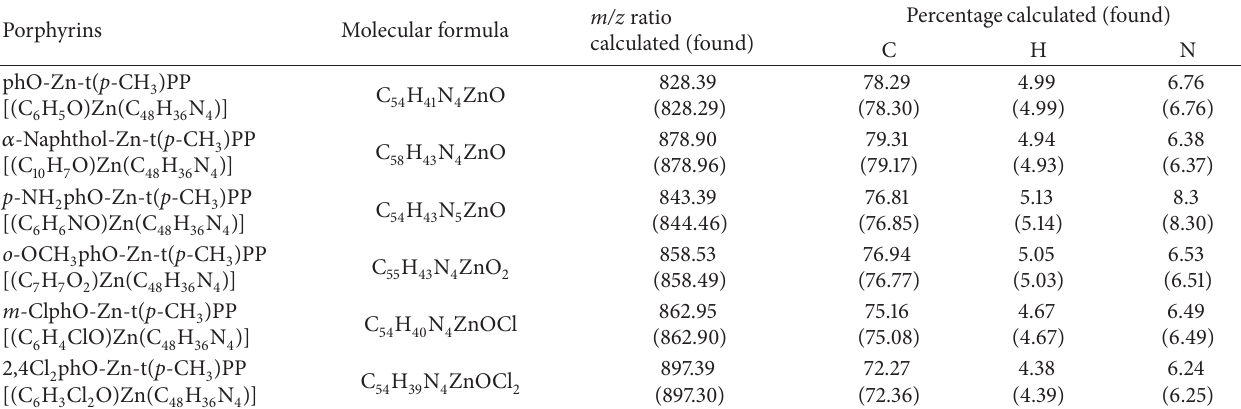
Table 5: Mass data ( m/z ratio) and elemental analytical data of X-Zn-t( p -CH calculated values. Porphyrins Molecular formula